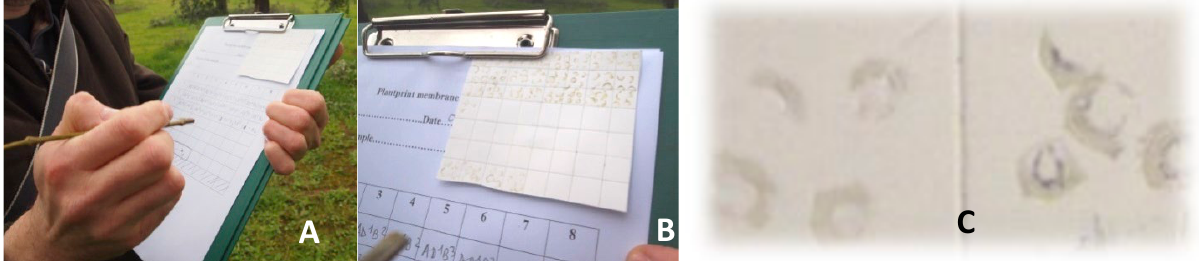
Figure 2. A) Printing of olive twigs in the field; B) detail of the nitrocellulose membrane: each sample is printed in two different grids and in each grid four prints representative of different branches of a tree canopy are blotted; C) purple col- oration observed on stem sections of Xf infected olive samples (right), negative control